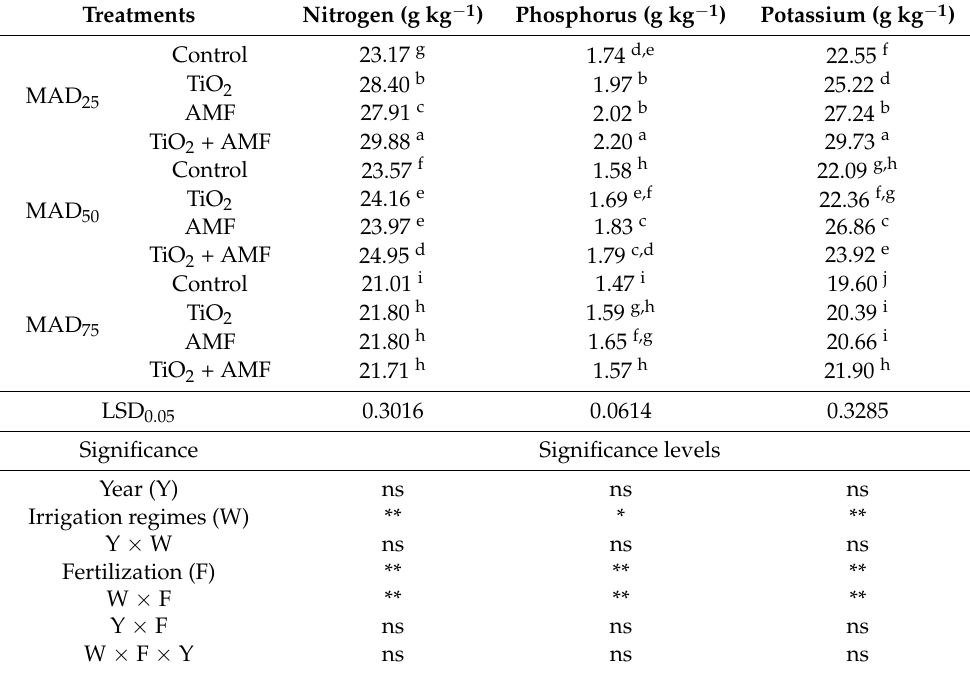
Table 1. The concentration nitrogen (N), phosphorus (P), and potassium (K) of sage in different irrigation regimes and fertilizer